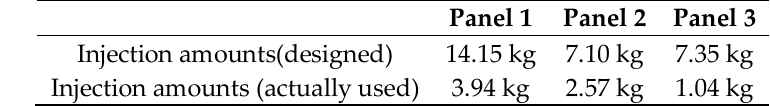
Table 3. Injection